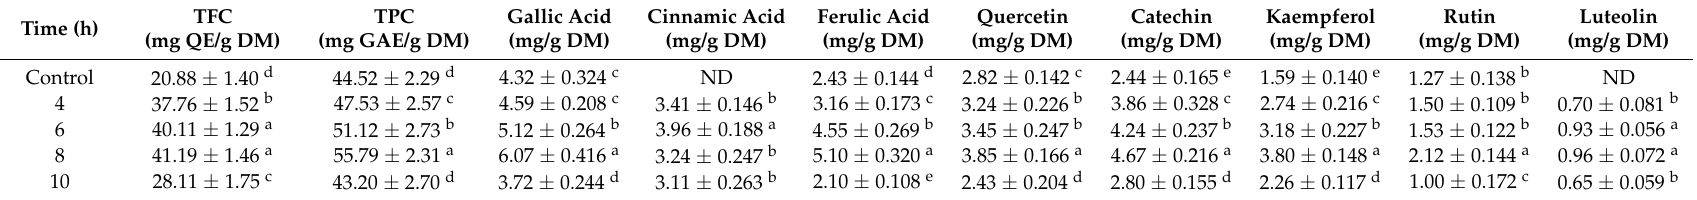
Table 2. Effect of UV-B irradiation time on TFC, TPC and individual flavonoid and phenolic acids content from sweet basil leaf extracts (UV-B: 3.60 W/m 2